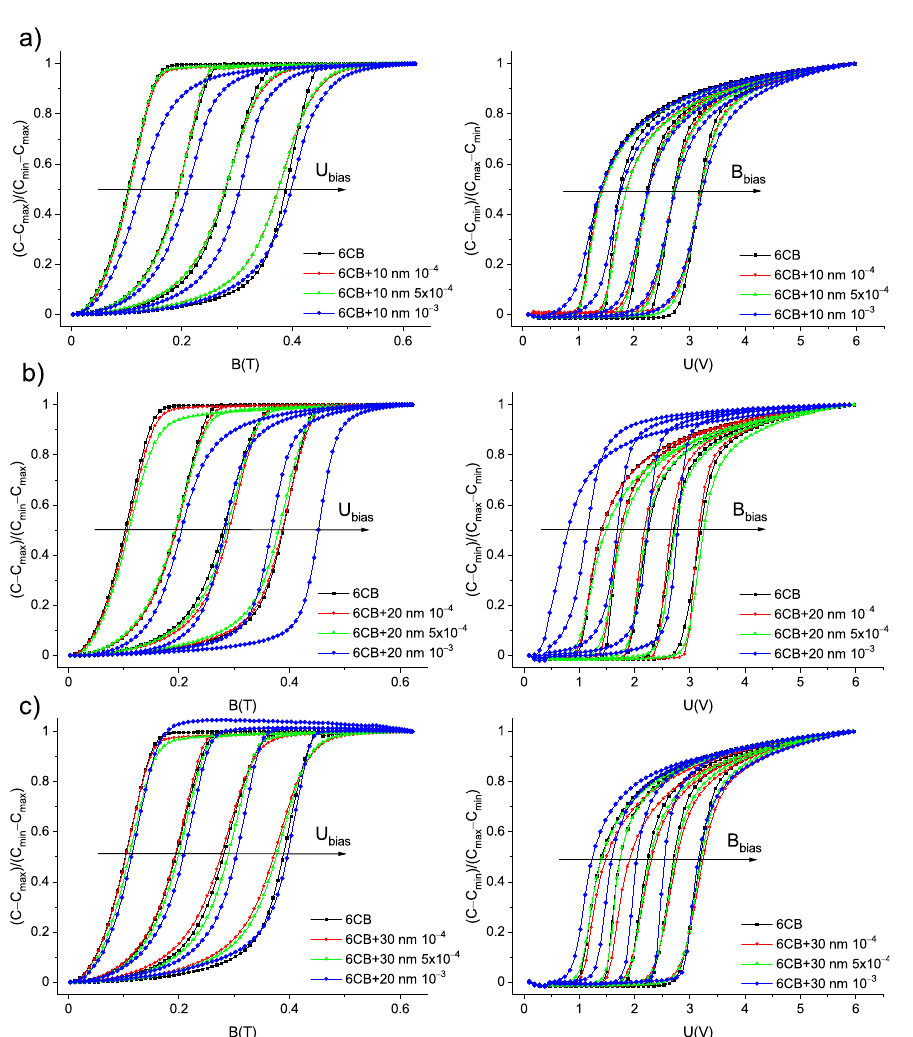
Figure 7. Dependencies of reduced capacitance on magnetic and electric field for various bias voltages U bias = 1, 1.5, 2, and 2.5 V and bias magnetic fields B bias = B = 0.1, 0.2, 0.3, 0.4, and 0.5 T, respectively, for pure 6CB and composites containing ( a ) 10 nm, ( b ) 20 nm ( c ), and 30 nm particles. The curves shift from the lowest bias voltage and magnetic field on the left to the highest on the